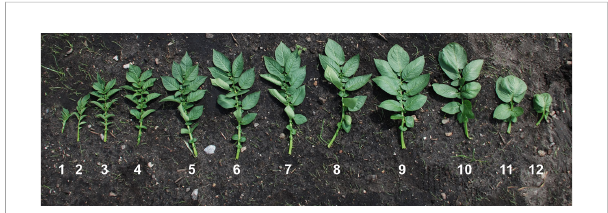
FIGURE 1 Leaf positions. One replicate of all leaves from a single plant at 51 days after planting. Numbers indicate leaf position, 1 being the youngest and 12 the